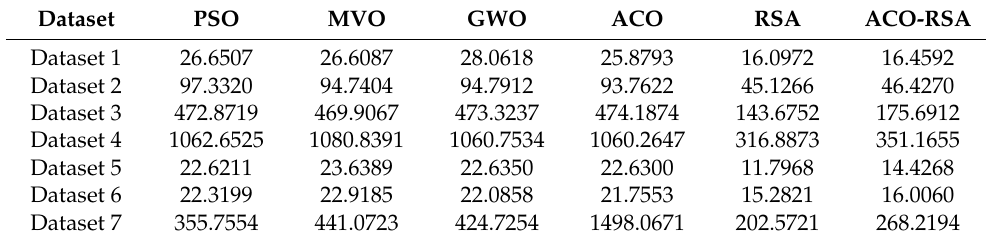
Table 6. The Avg CT of the ACO-RSA and the other